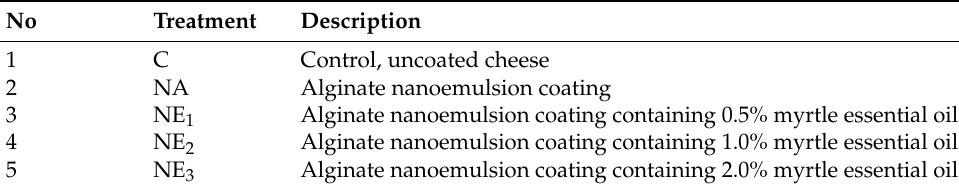
Table 6. List of treatments in the present